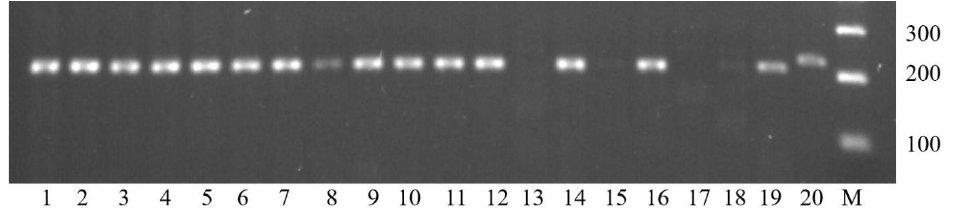
Figure 1. Results of 1RS detection in winter bread wheat cultivars using SCM9. 1, Kavkaz; 2, Kurs; 3, Kollega; 4, Vassa; 5, Zhiva; 6, Vita; 7, Ayvina; 8, Yuka; 9, Urup; 10, Antonina; 11, Vid; 12, Videya;